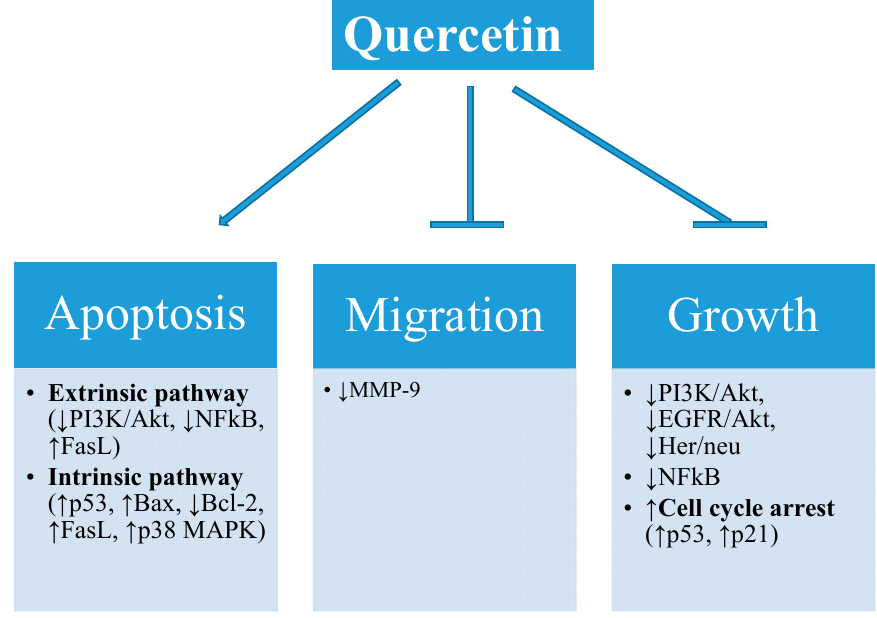
Figure 1. Cellular processes modulated by quercetin ( ↓ : downregulate and ↑ : upregulate).